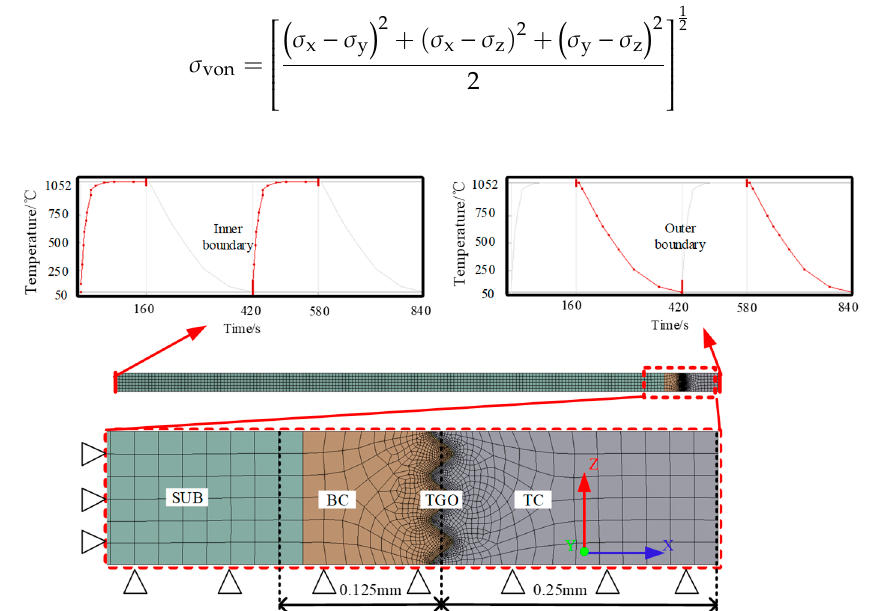
Figure 6. Finite element (FE) model and boundary conditions of the ceramic metal tube.